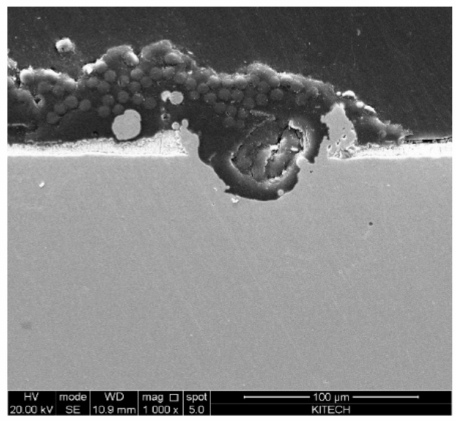
Figure 7. The SEM image of the fractured cross-section for the laser fusion-welded CFRP and zinc-coated steel joint with laser patterned grooves after the tensile shear test.